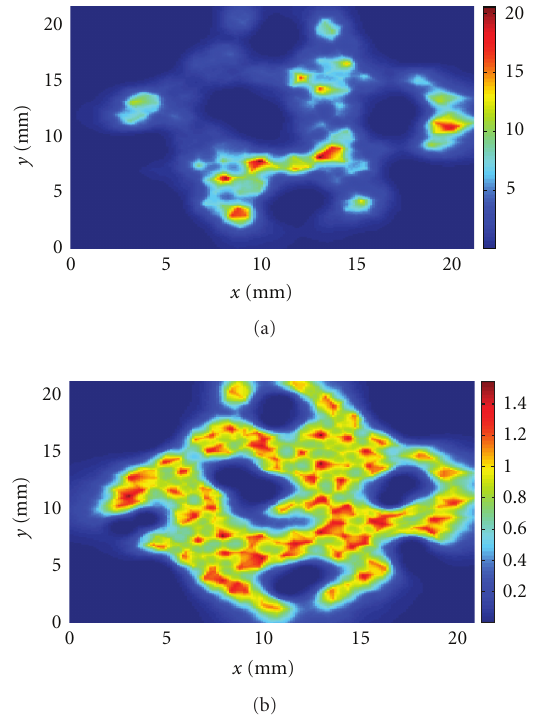
Figure 11: Total thermal dose accumulation in the midplane for the spiral insonation treatment (a) with fixed power and (b) with variable